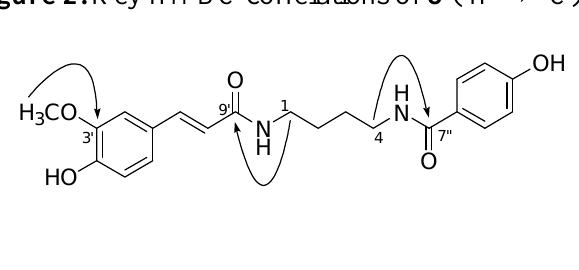
Figure 2. Key HMBC correlations of 8 ( 1 H → 13